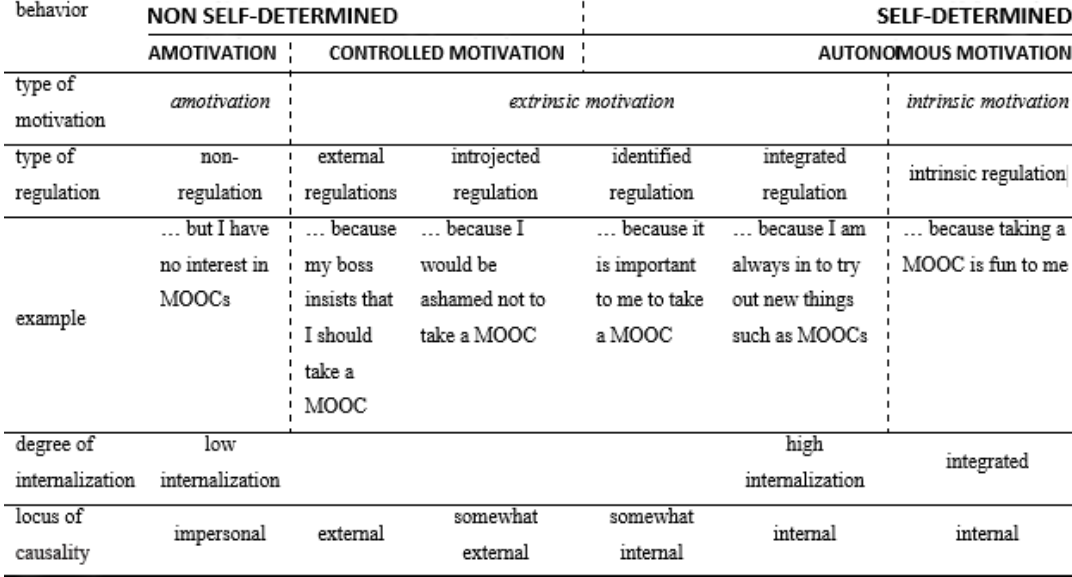
Figure 2 : The different types of motivation according to